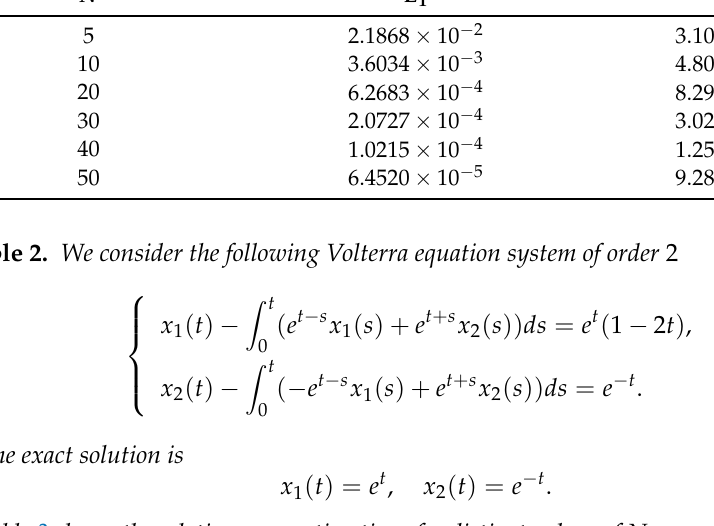
Table 2. Computed relative error estimations for Example 1 from some values of N . N E